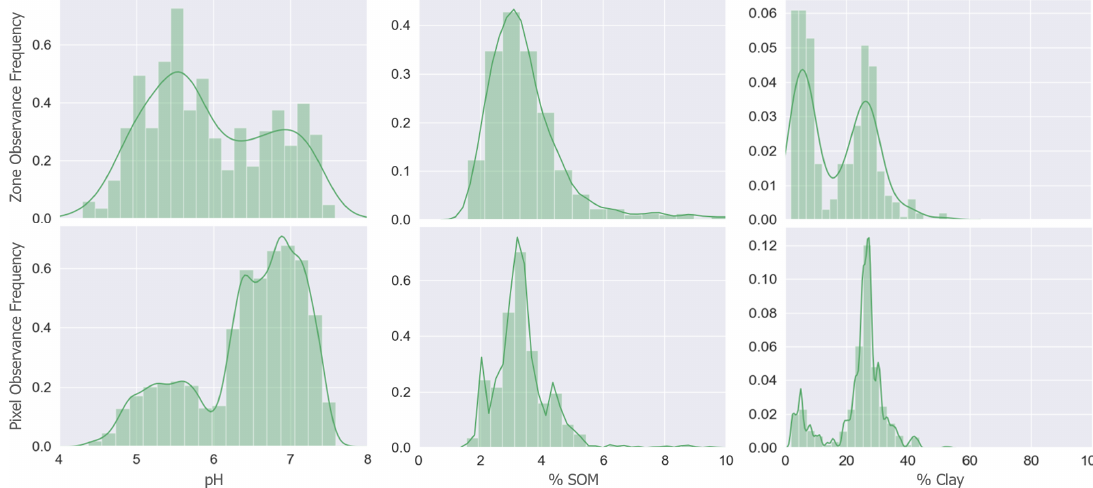
Figure 5. Histograms of the measured pH, soil organic matter (SOM) and clay content of the taken samples with respect to observance frequencies at zone (top) and pixel level